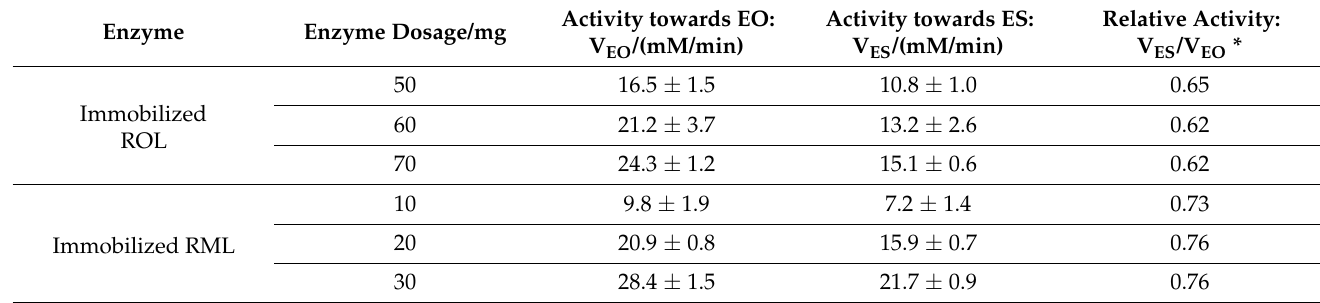
Table 1. Activity profiles of ROL and RML in transesterifications.